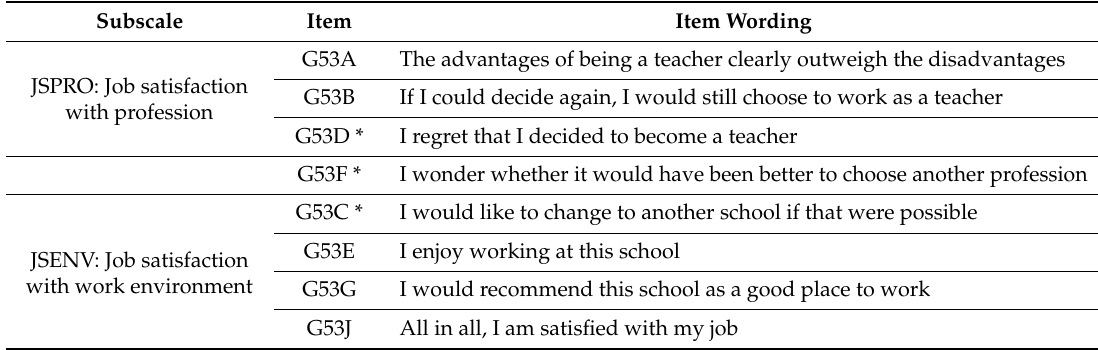
Table 1. Item labels and wordings of the TALIS 2018 teacher job satisfaction scale. Subscale Item Item